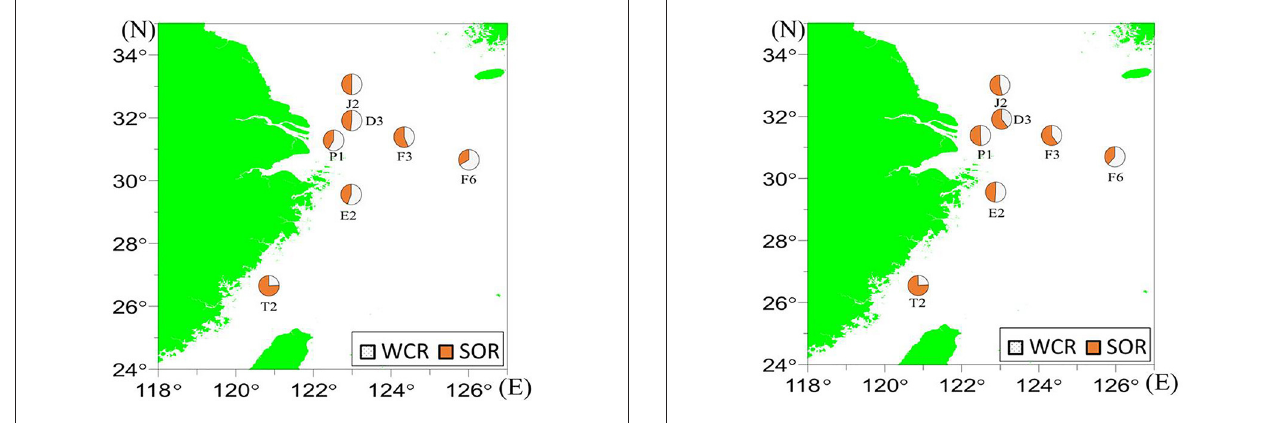
FIGURE 6 | The WCR and SOR% contributions to total AOU in the near-bottom waters in July 2018 as revealed by the IR model.